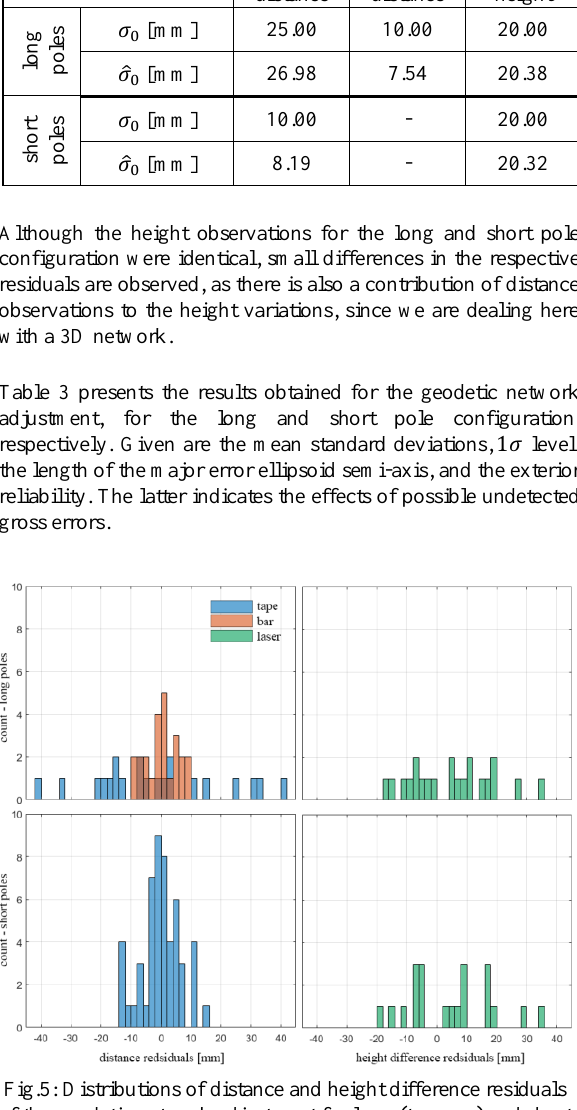
Fig.4: Typical UW image with long pole GCP and calibration frame with color calibration